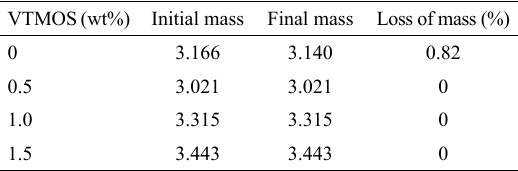
Table 6. Loss of mass of HMWPE and VTMOS crosslinked HMWPE samples during the wear sliding